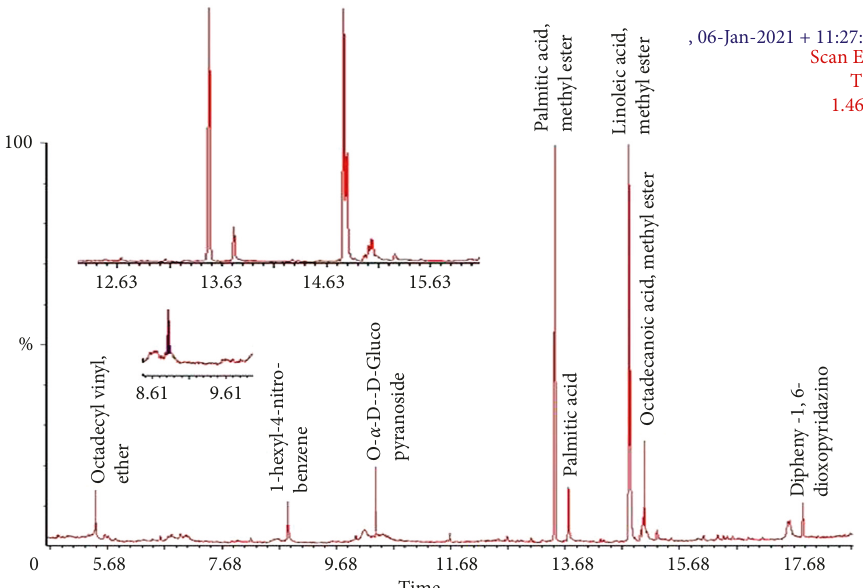
Figure 2: GC-FID chromatogram of aerial parts of essential oil of CS identified peaks is given according to the serial number of compounds in Table